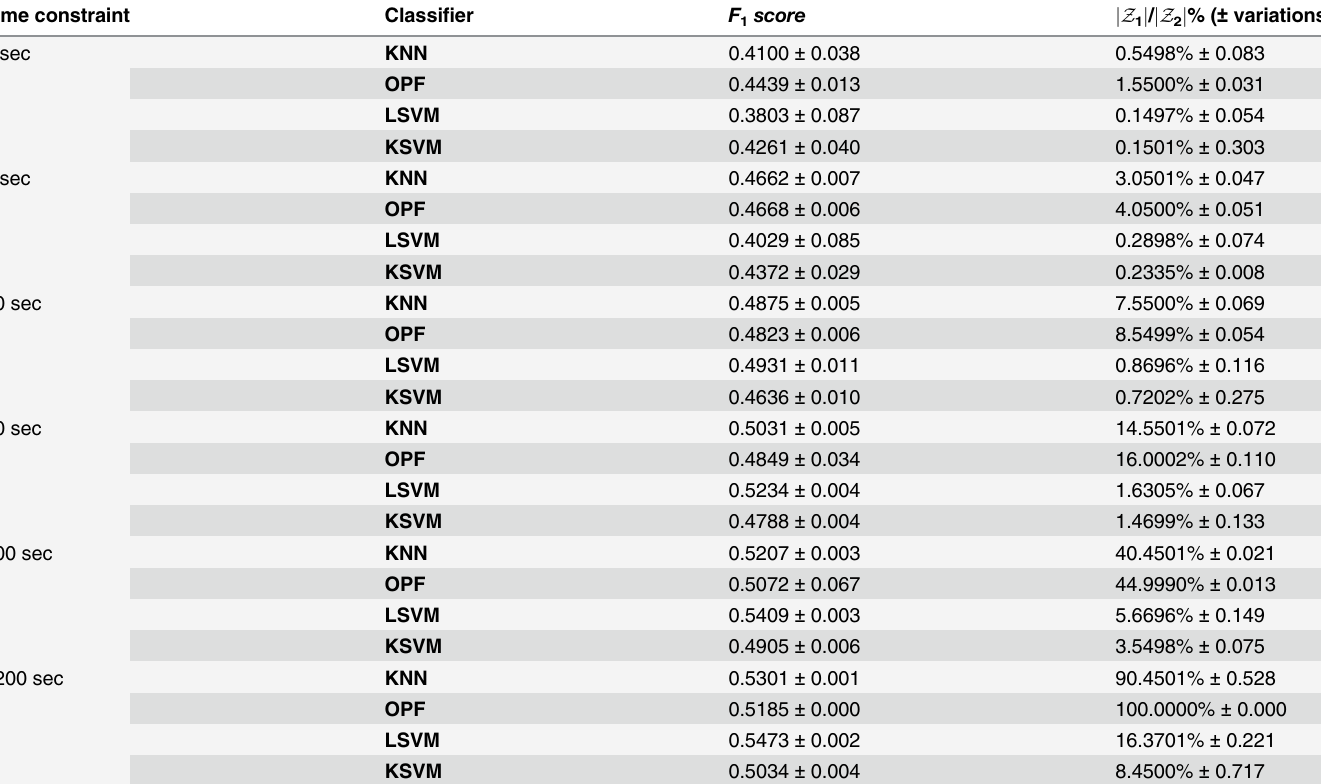
Table 11. SensIT dataset: Predictivity performance over Z 3 and final training set size, j Z 1 j as a percentual of j Z 2 j , for each classification model and learning time constraint using random